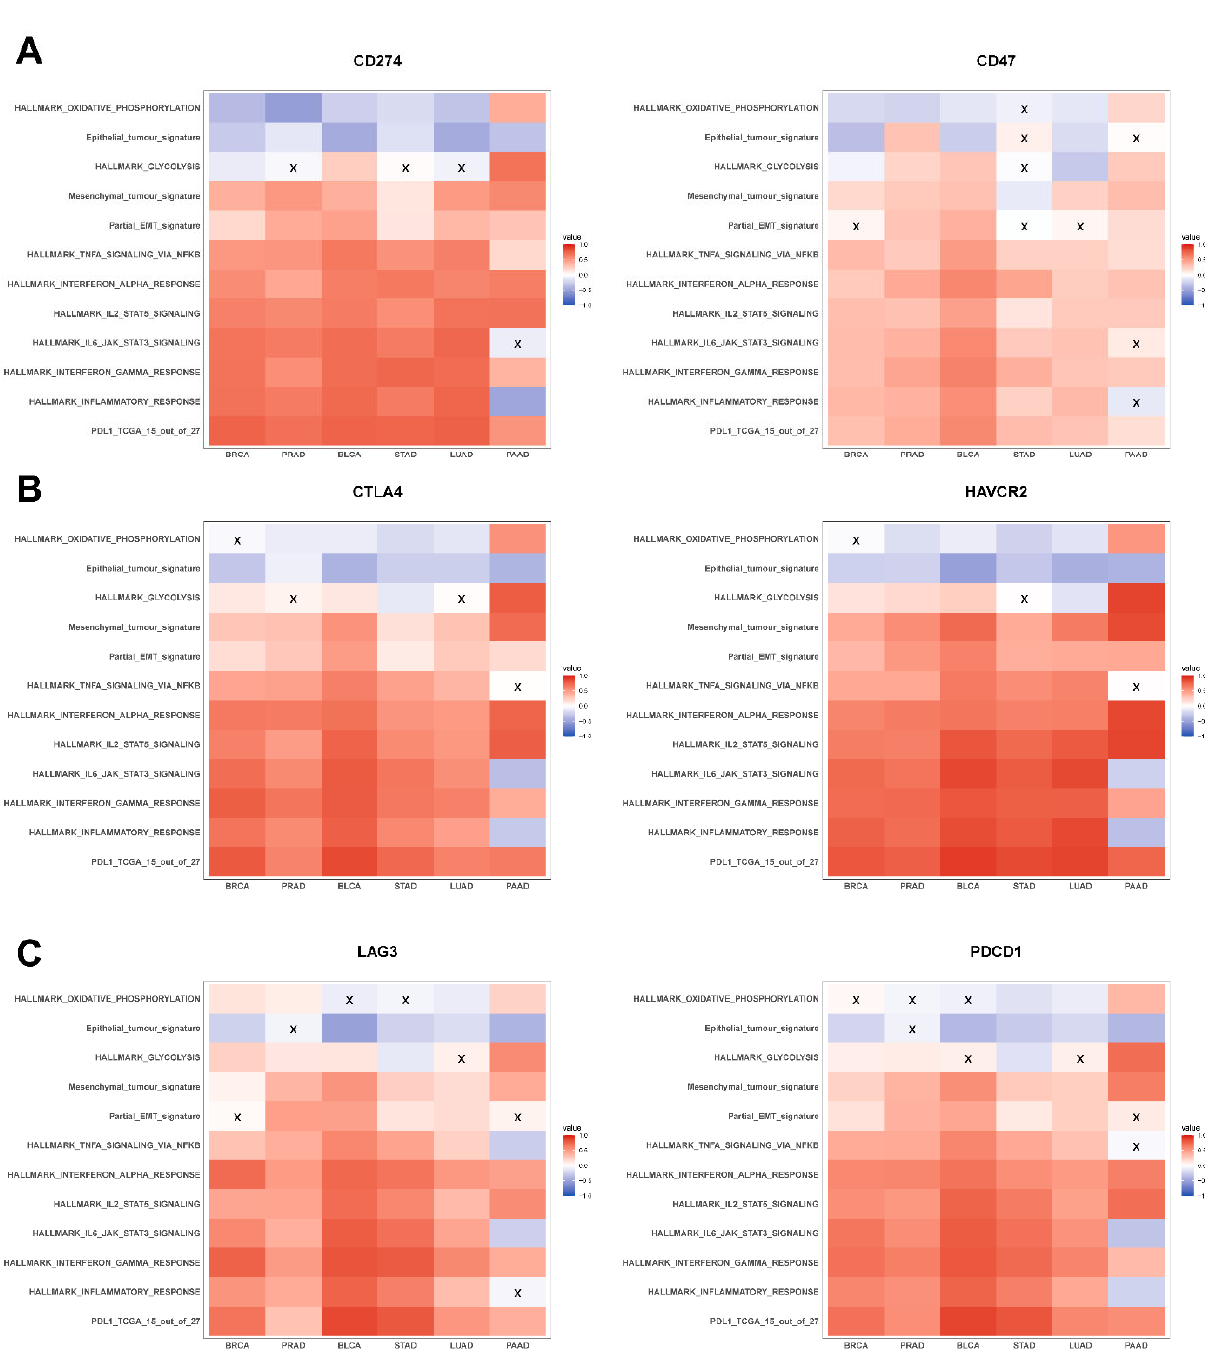
Figure 3. Association of immune checkpoint markers with several hallmark gene signatures in TCGA cohorts: ( A ) heatmap illustrating the Spearman correlation coefficients between different hallmark gene signatures with CD274 ( left ) and CD47 gene expression ( right ) in BRCA, PRAD, BLCA, STAD, LUAD, and PAAD. Insignificant correlations ( p > 0.05) are marked with ‘X’. Same as ( A ) but for ( B ) CTLA4 ( left ) and HAVCR2 gene expression data ( right ) and ( C ) LAG3 ( left ) and PDCD1 gene expression data ( right ).